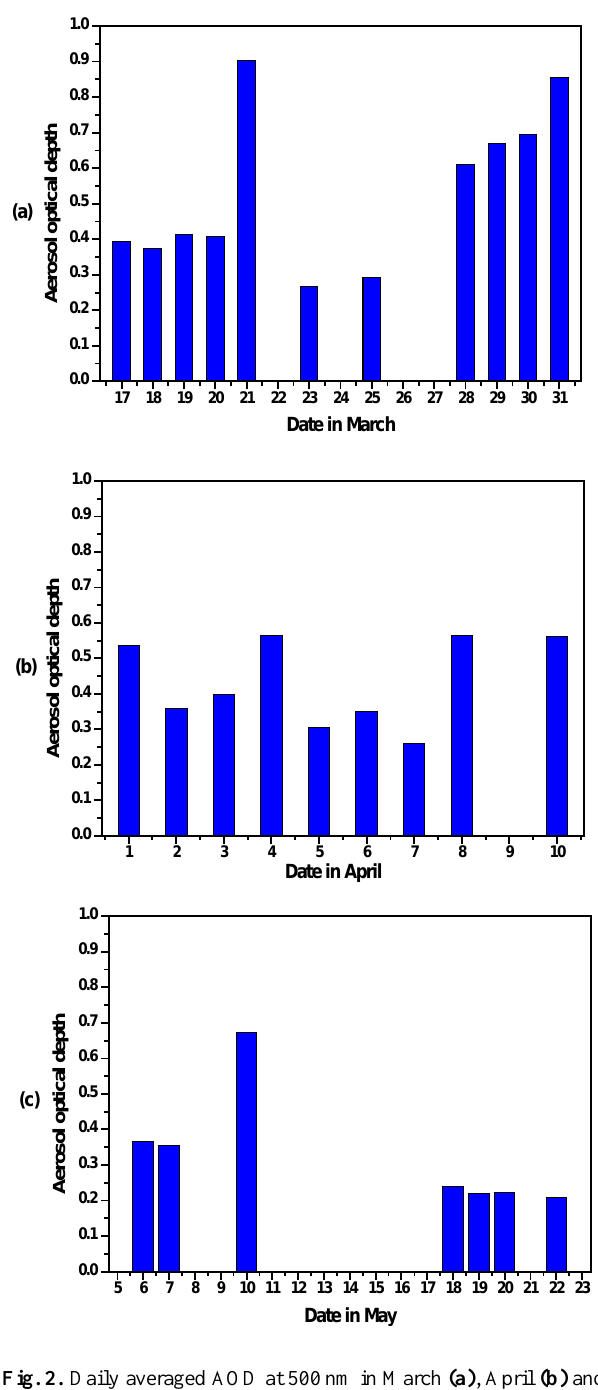
Fig. 2. Daily averaged AOD at 500 nm in March (a), April (b) and May (c).